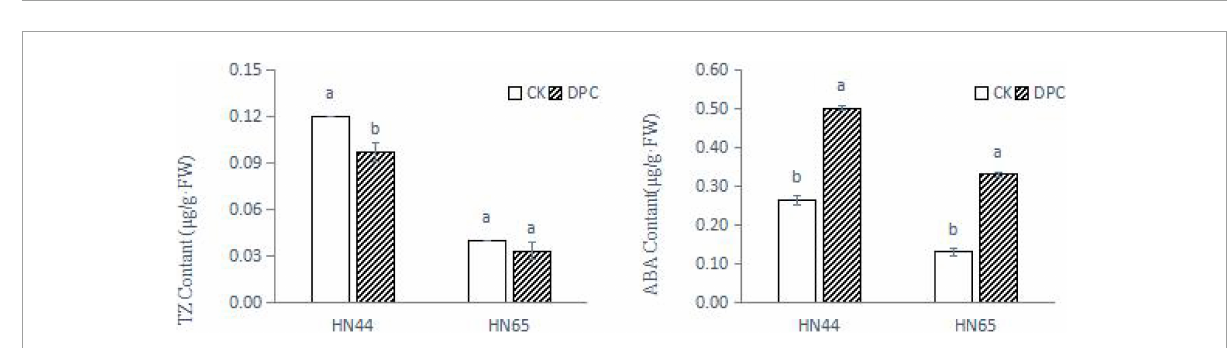
FIGURE2 Changes of soybean hormone content after spraying DPC. Each histogram is the mean of n = ... Vertical bars are ± 1 S.E. Within each variety, different letters indicate significant differences at P < 0.05.